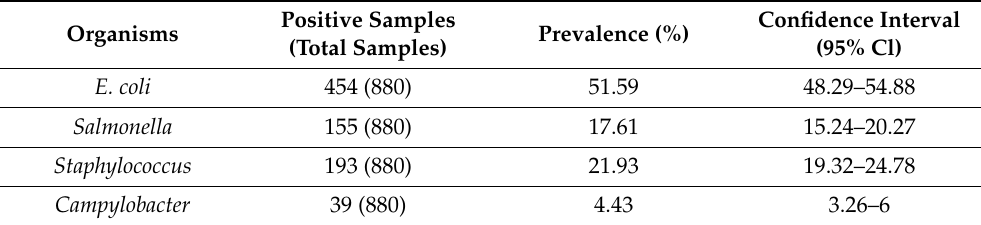
Table 2. Prevalence of AMR pathogen in poultry source food products and